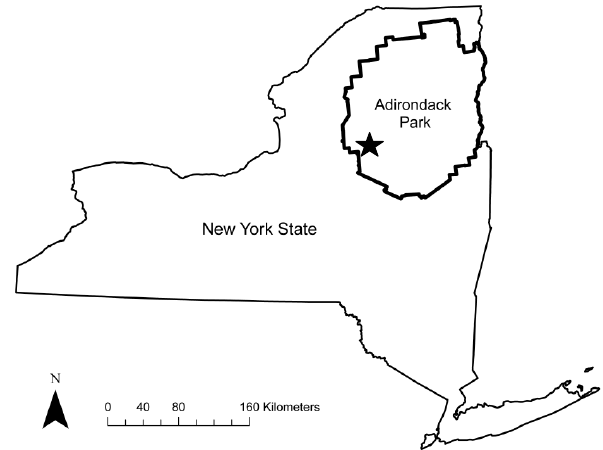
Fig. 1. The Adirondack Park located within New York State. The Figure 1. The Adirondack Park located within New York State. The star indicates the location of star indicates the location of Grass Pond watershed in the south- Grass Pond watershed in the southwestern region of the Adirondacks. western region of the